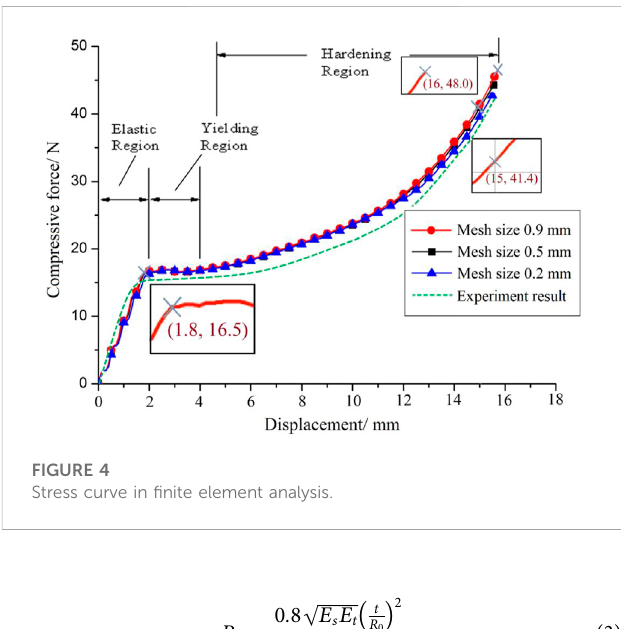
FIGURE 4 Stress curve in fi nite element